Question: What does this figure show? Answer in one sentence.
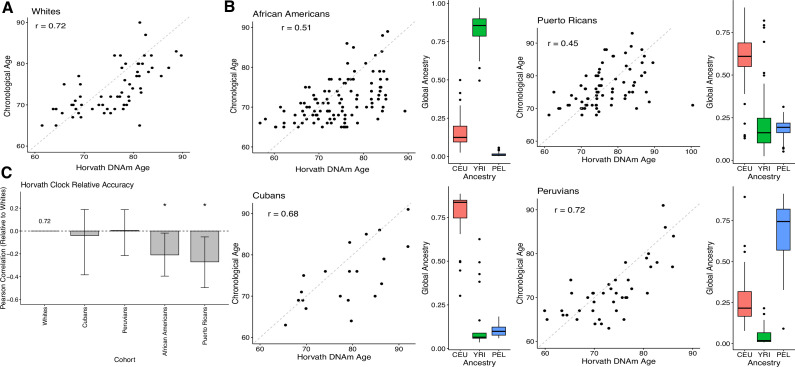
Answer: Methylation clock accuracy is lower in cohorts with substantial African genetic ancestry. ( A ) Pearson correlation between chronological age and DNAm age predicted by the Horvath clock for controls in the White MAGENTA cohort. The correlation of r = 0.72 \begin{document}$r=0.72$\end{document} is consistent with previous studies of similar age groups. ( B ) Pearson correlation between chronological age and DNAm age predicted by the Horvath clock for the genetically admixed cohorts in MAGENTA. For each cohort, the adjacent boxplots display the distribution of global ancestry proportions: European (CEU, red), African (YRI, green), and Amerindigenous (PEL, blue). The cohorts with substantial African ancestry—African Americans and Puerto Ricans—exhibit lower correlations ( r = 0.51 \begin{document}$r=0.51$\end{document} and 0.45, respectively) compared to the Cubans ( r = 0.68 \begin{document}$r=0.68$\end{document} ) and Peruvians ( r = 0.72 \begin{document}$r=0.72$\end{document} ). ( C ) Relative accuracy of the Horvath clock across cohorts compared to Whites. The bar plot shows the difference in Pearson correlation coefficients relative to the White cohort baseline ( r = 0.72 \begin{document}$r=0.72$\end{document} ). Asterisks indicate a statistically significant difference from the baseline (* p < 0.05). Error bars denote 95% confidence intervals for relative correlation differences (Zou's method).